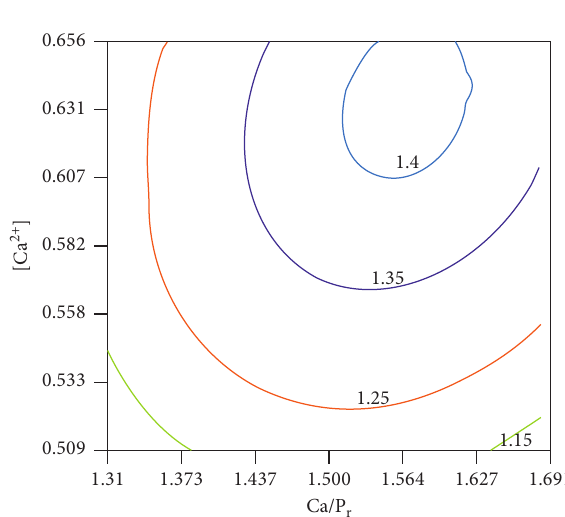
Figure 2: Isoresponse contour plot for % O T � 40 ° C, and D �